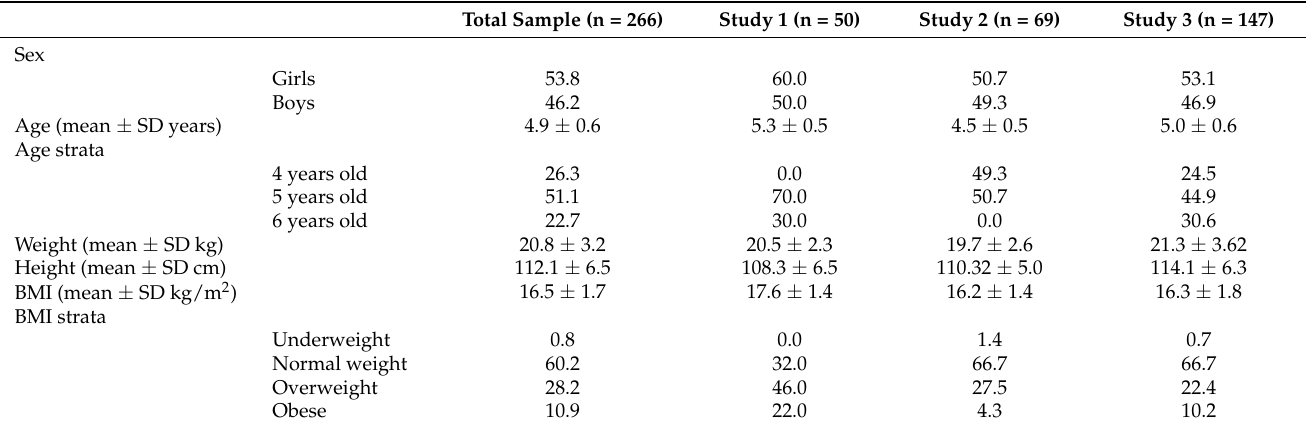
Table 1. Descriptive characteristics of the included sample.